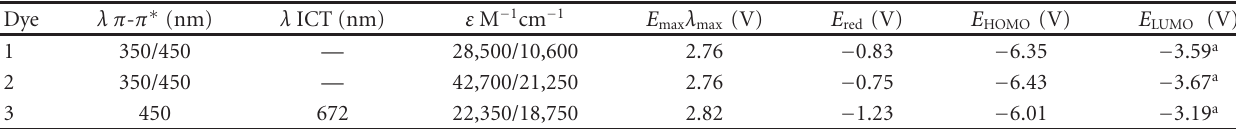
Table 1: UV-Vis absorption data (in ethanol) and cyclic voltammetry data (in 0.1M Bu 4 NPF 6 /DMF, scan rate 100mVs − 1 , reference electrode Ag/AgCl) from compounds 1–3.